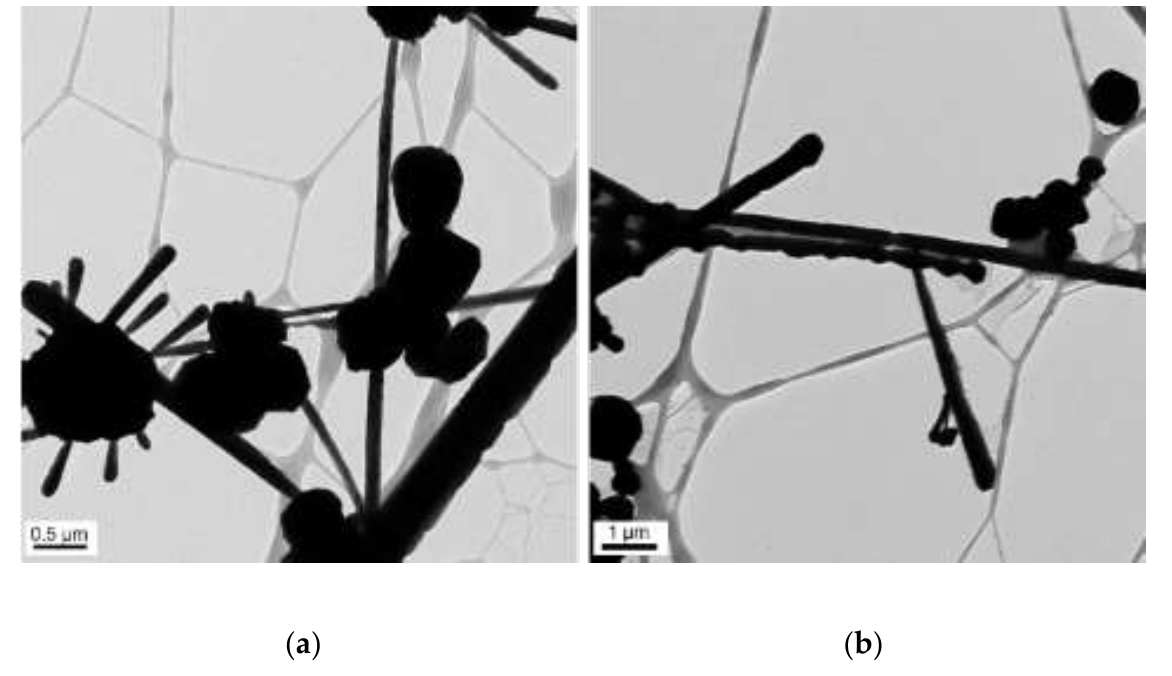
Figure 15. TEM images of copper nanowires with 12 M of NaOH: ( a ) scale bar 0.5 µ m; ( b ) scale bar 1 µ m.